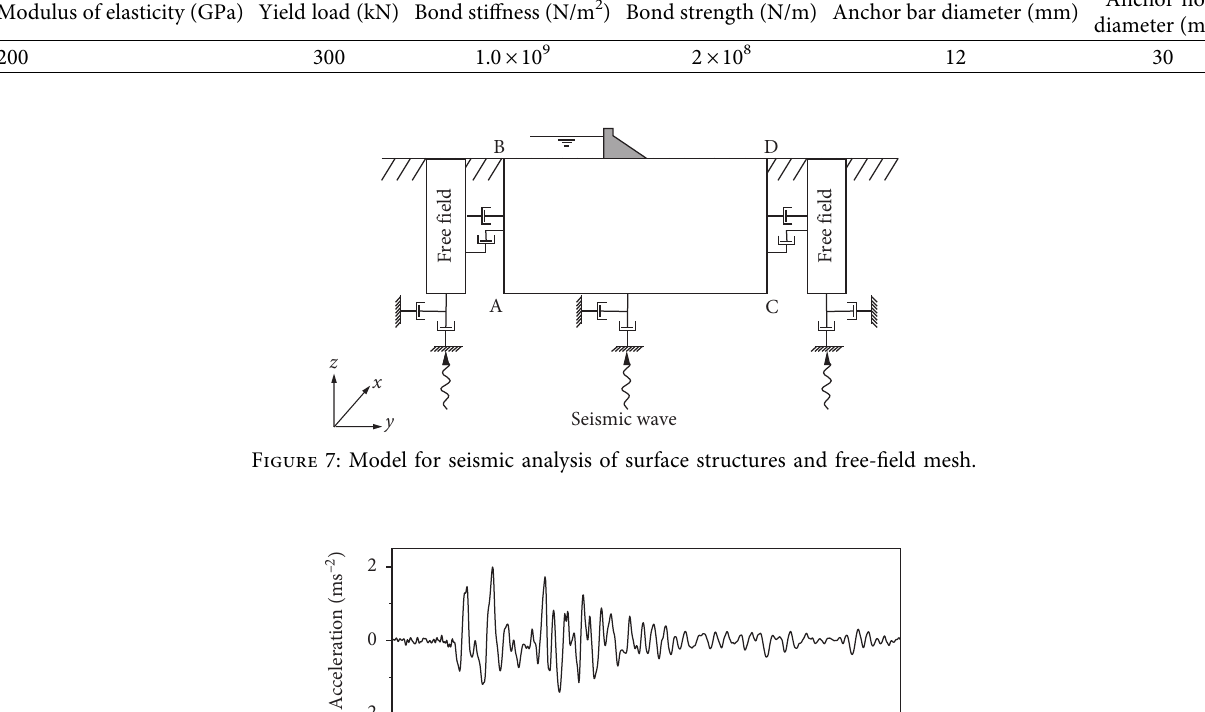
Table 2: Material parameters of the small bolt.